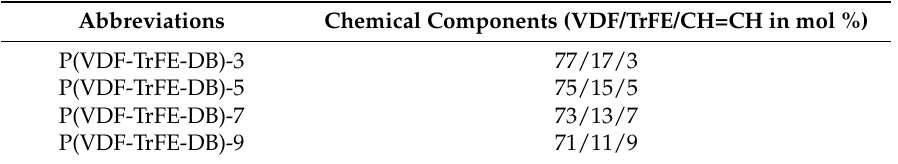
Table 1. Abbreviations for the materials and chemical components.